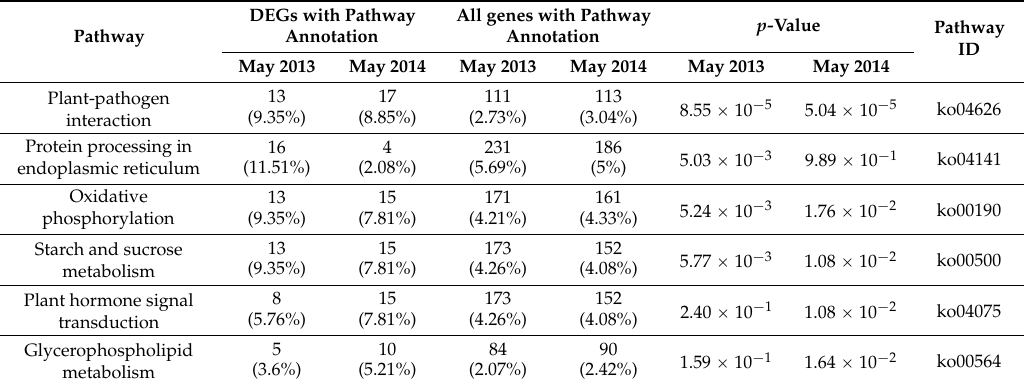
Table 2. Differentially expressed unigenes with significantly enriched pathways. Pathway DEGs with Pathway All genes with Pathway Annotation